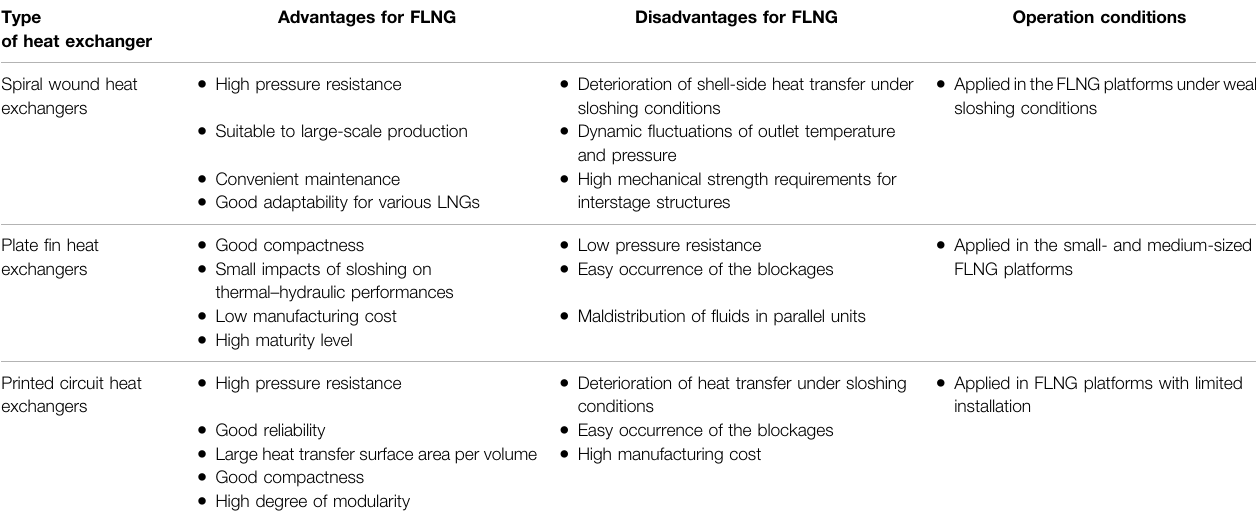
TABLE 1 | Comparison of heat exchangers for FLNG (Hasan et al., 2009; Oh et al., 2009; Pacio and Dorao, 2011; Ma et al., 2016; Zheng et al., 2021; He et al., 2022; Ma et al., 2022). Type Advantages for FLNG Disadvantages for FLNG Operation of heat exchanger